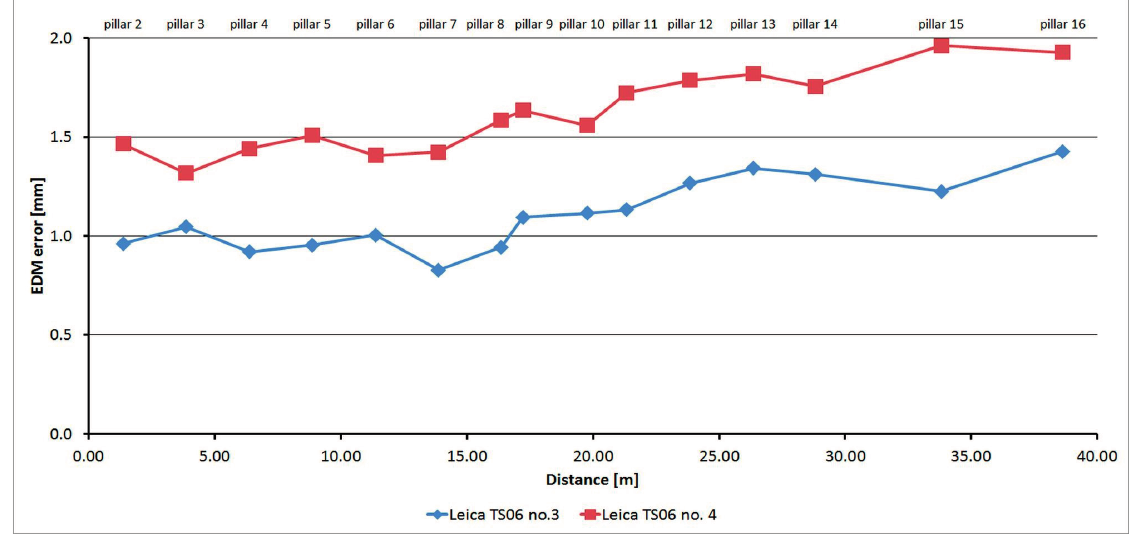
Figure 27. Comparison of absolute errors of two Leica TS06